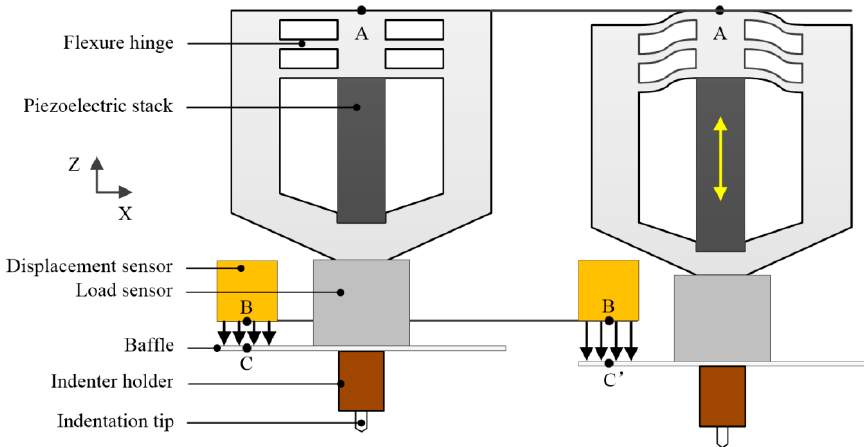
Figure 4. Schematic diagram of piezoelectric driving method [33].